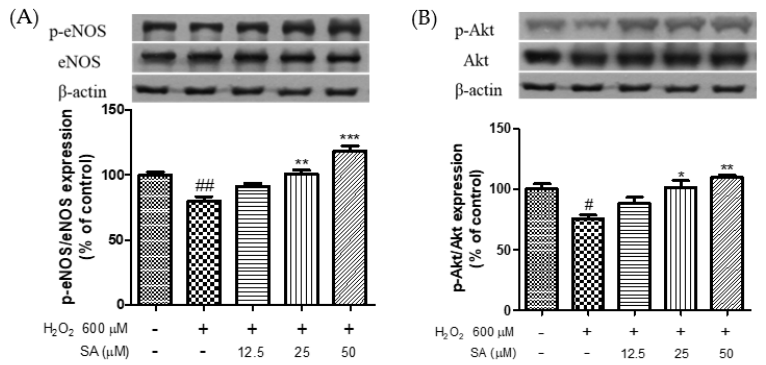
Figure 5. Effect of sinapic acids on p-eNOS ( A ) and p-Akt ( B ) protein expression against hydrogen peroxide (600 µ M) in EA.hy 926 cells. Each value was expressed as the mean ± standard error ( n = 3). Statistical significance was analyzed using the Tukey test. # p < 0.05 and ## p < 0.01 versus nontreated cells. * p < 0.05, ** p < 0.01, and *** p < 0.001 versus hydrogen-peroxide-treated cells.